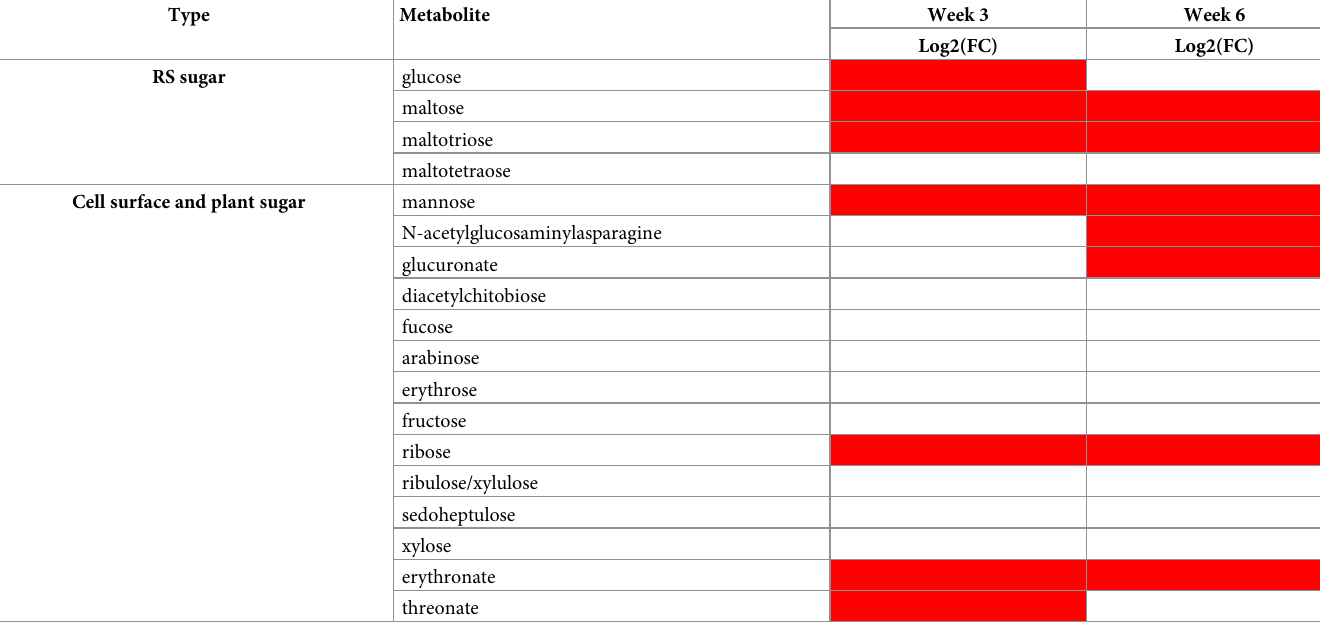
Table 3. Sugars derived from resistant starch and other sugars detected via metabolomic screening in fecal samples taken at weeks 3 and 6 from cats fed LRS or HRS food.